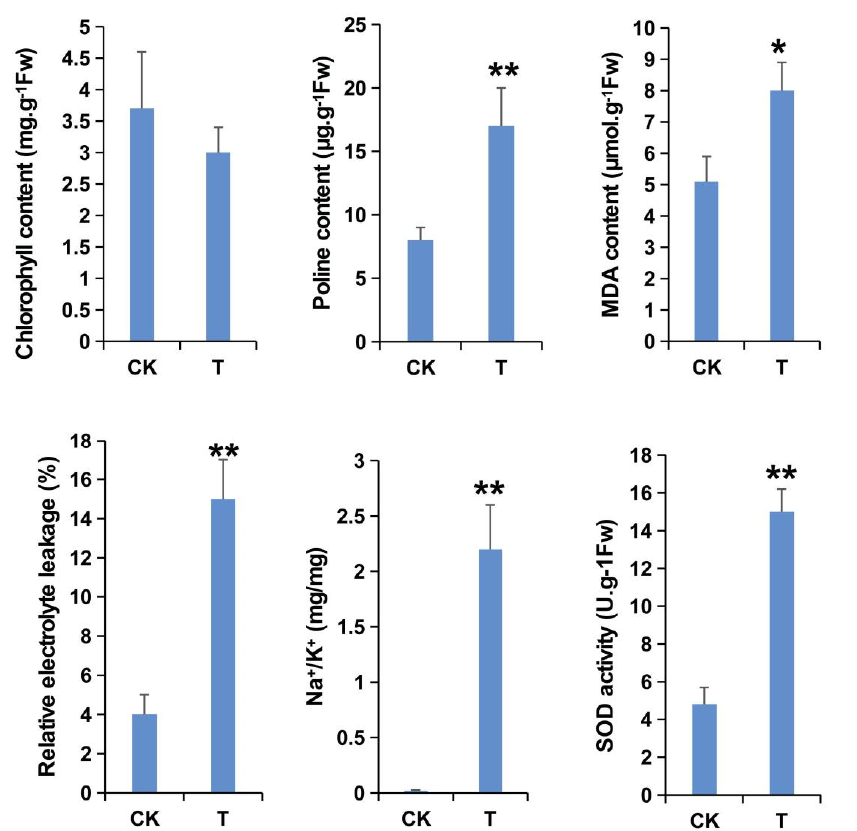
Figure 1. Physiological indices of FL478 plants under salt stress (T) and control (CK) conditions. Error bars indicate the standard deviation for three replicates. Asterisks indicate a significant difference between the control and salt stress conditions (* p < 0.05, ** p < 0.01; Student’s t -test).